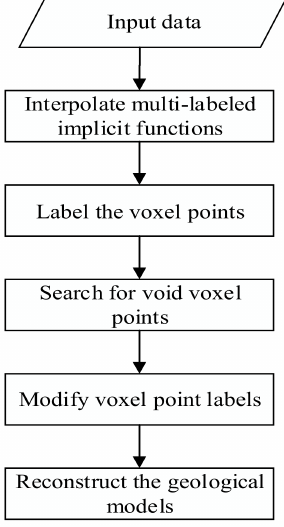
Figure 2. Overall flow